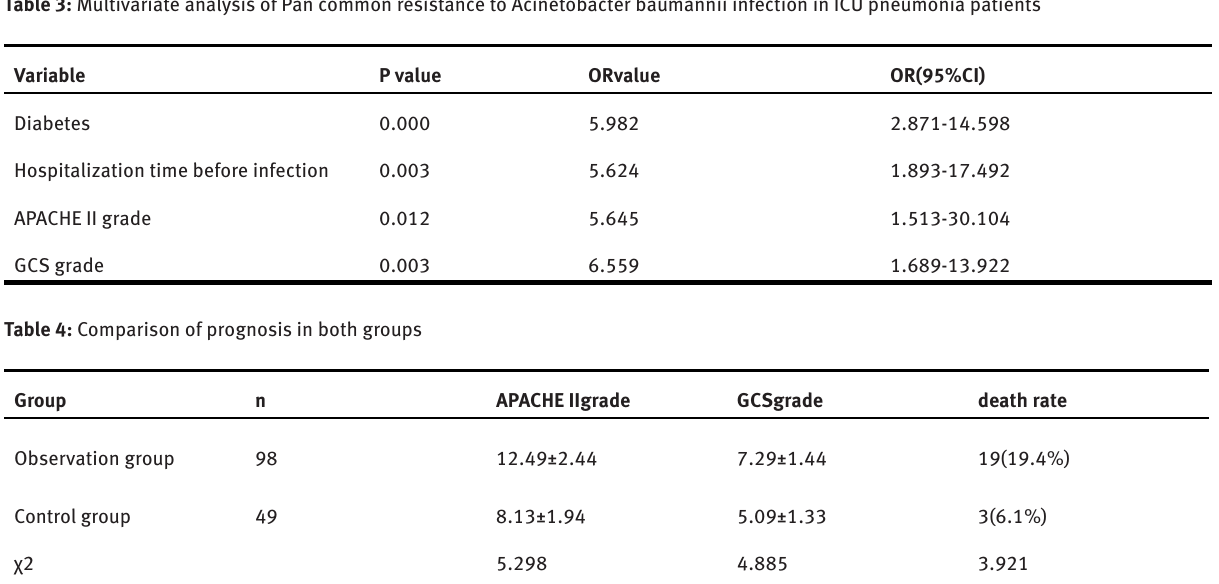
Table 3: Multivariate analysis of Pan common resistance to Acinetobacter baumannii infection in ICU pneumonia patients